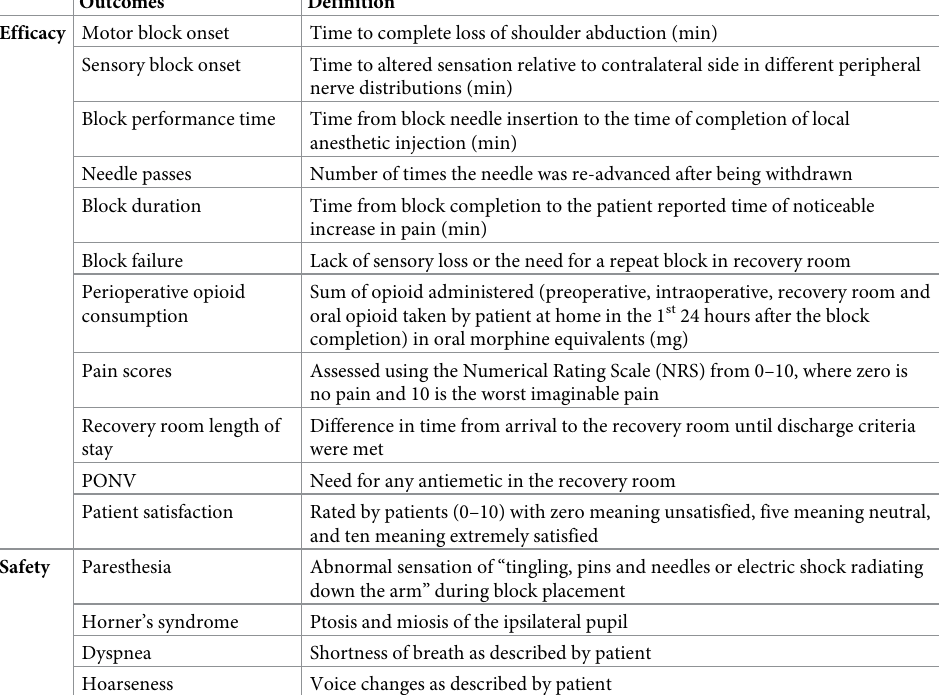
Table 1. Outcome